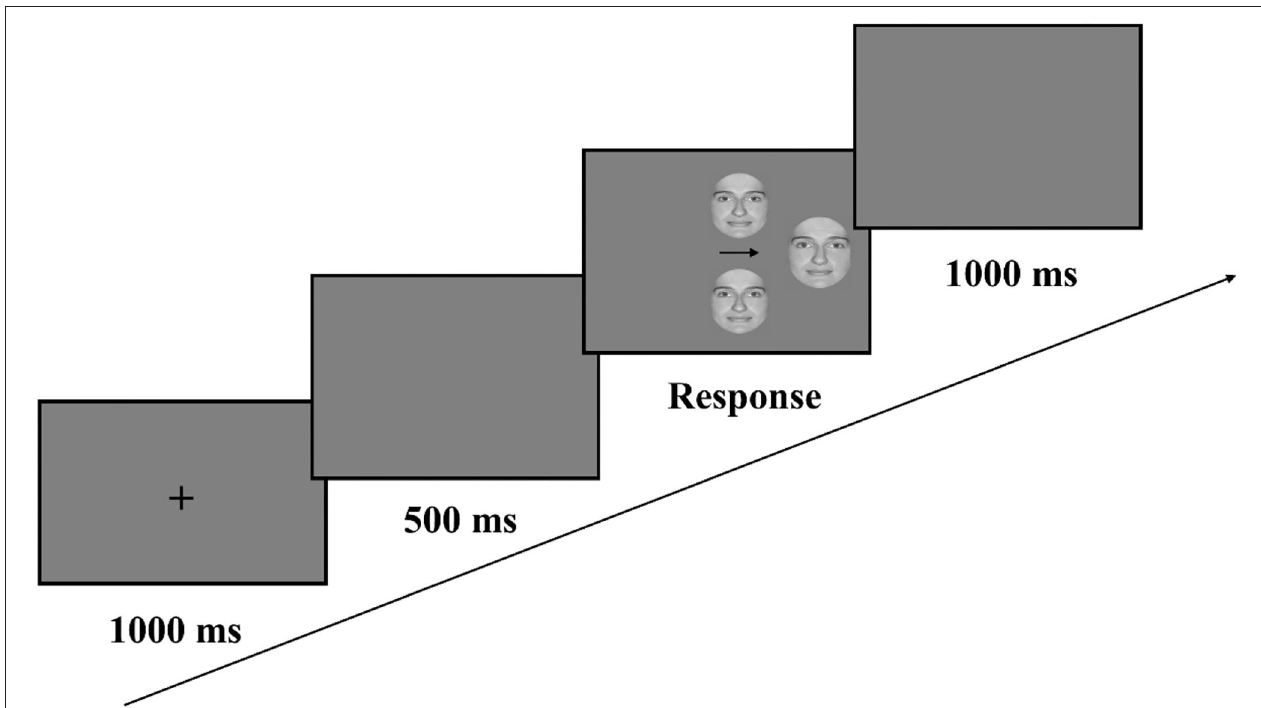
FIGURE 2 | Example of an upright Caucasian chimeric face